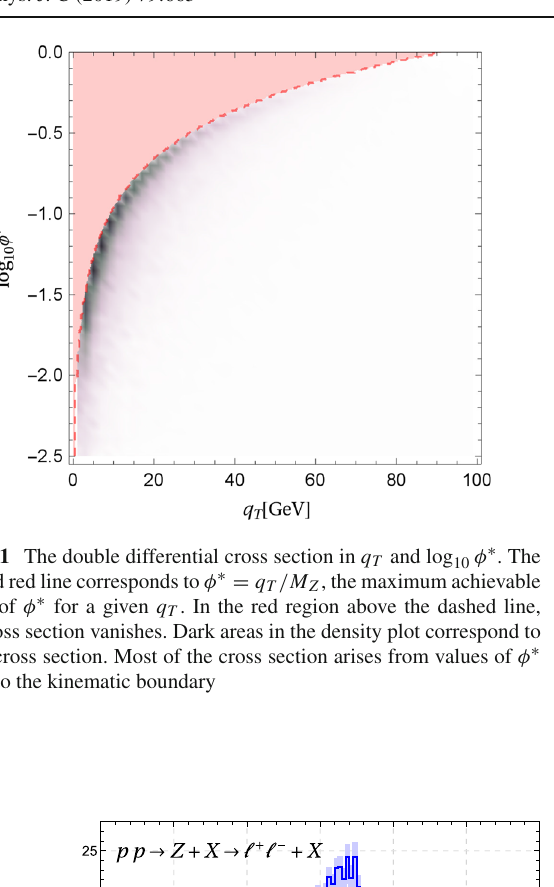
Fig. 12 Matched NNLL result for lepton momenta. We impose p (cid:4) √ s = 8TeV. Right: The μ + transverse momentum in W + production at production at